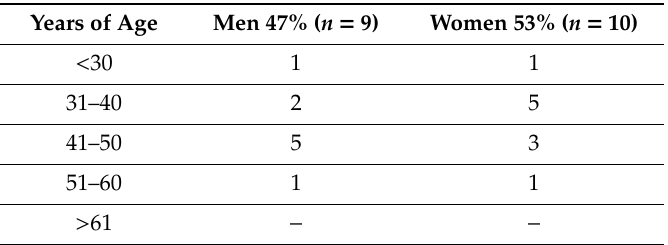
Table 1. Characteristics of the specialist ambulance nurses (SANs) (n =